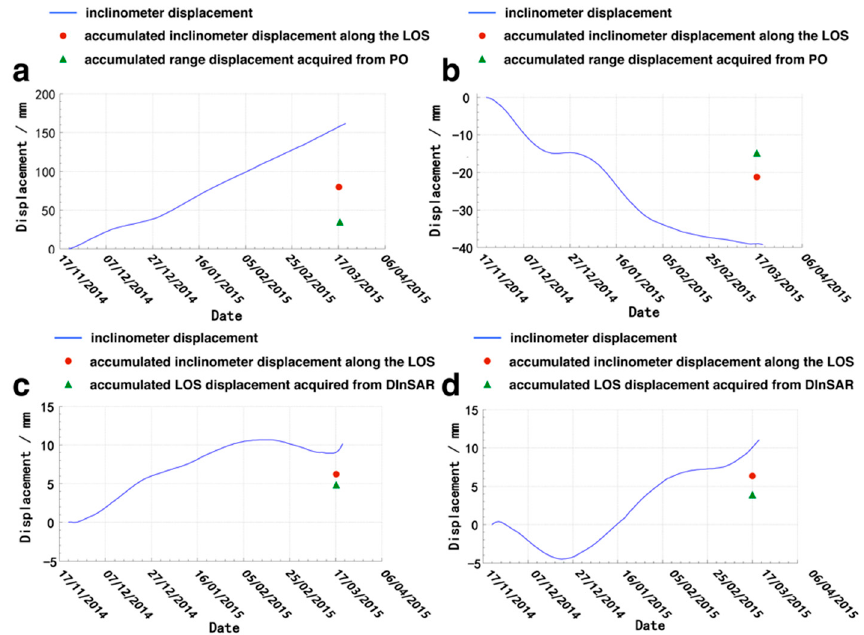
Figure 12. Comparisons of inclinometer displacements, accumulated inclinometer displacement along the LOS and accumulated hybrid-SAR LOS displacements of boreholes Bh1 ( a ); Bh2 ( b ); Bh3 ( c ); and Bh4 ( d ) measured from 21 November 2014–17 March 2015.